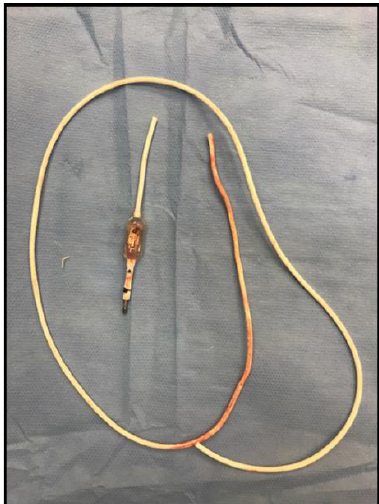
Figure 1 - Catheter extracted from a 14-year-old patient, implanted since birth. The patient presented intermittent headache and vomiting associated with a small subcutaneous collection in the cervical region.